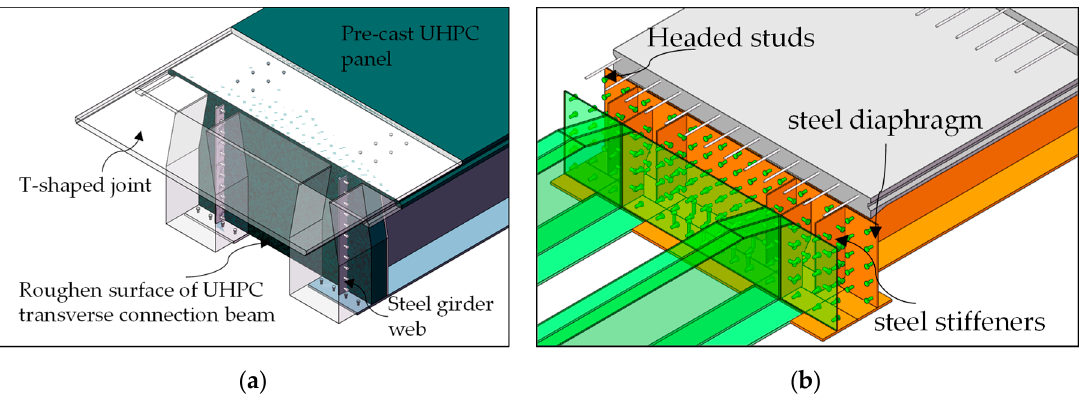
Figure 8. The design schematic of two T-shaped joints: ( a ) the first generation T-shaped joint; ( b ) the second generation T-shaped joint.